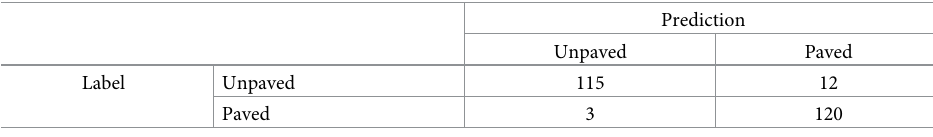
Prediction Paved